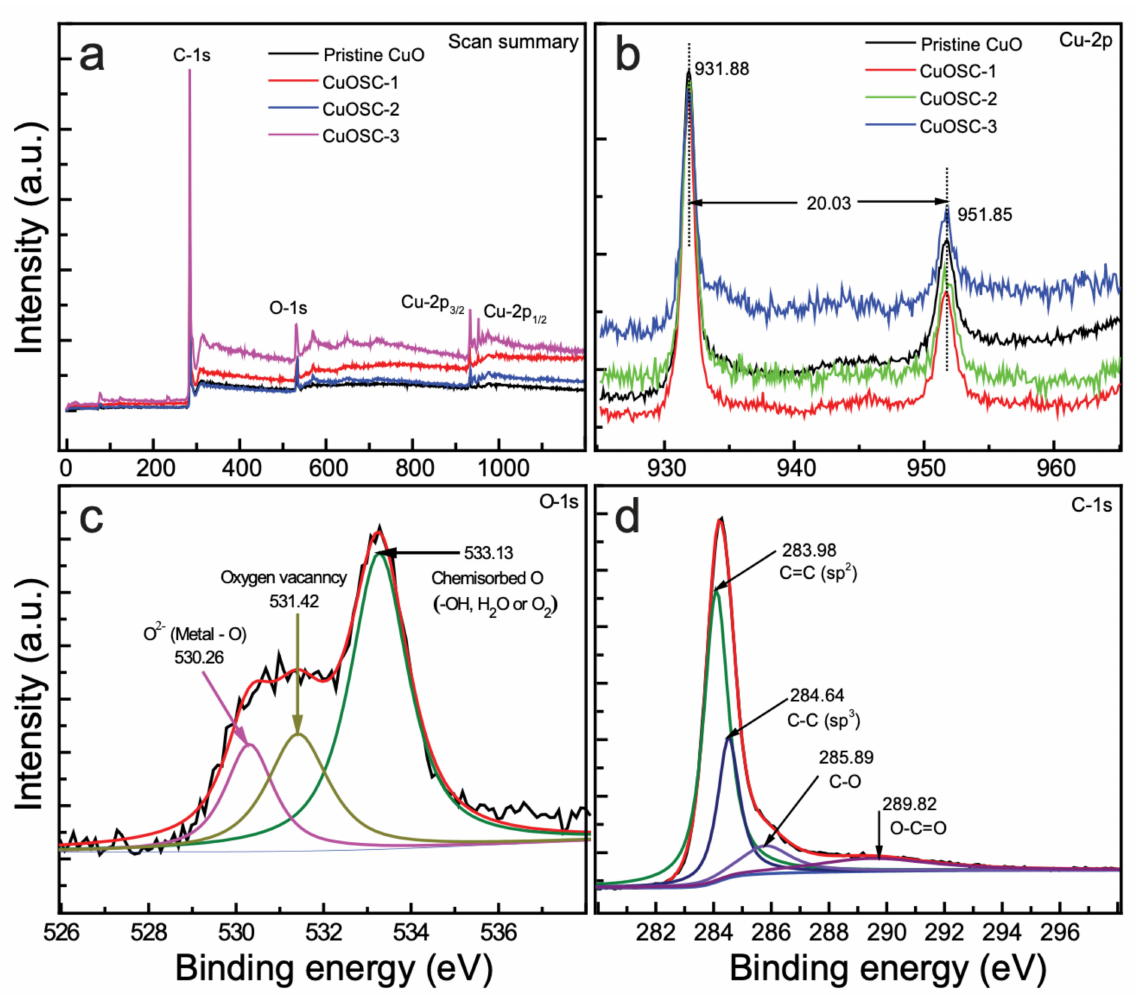
Figure 4. High-performance X-ray photoelectron spectroscopy (XPS) plots of the nanocomposites: ( a ) survey spectrum, ( b ) Cu-2 p scan showing Cu-2 p 3/2 and Cu-2 p 1/2 , ( c ) O-1 s core-level of CuOSC-3, and ( d ) C-1 s core-level spectra of